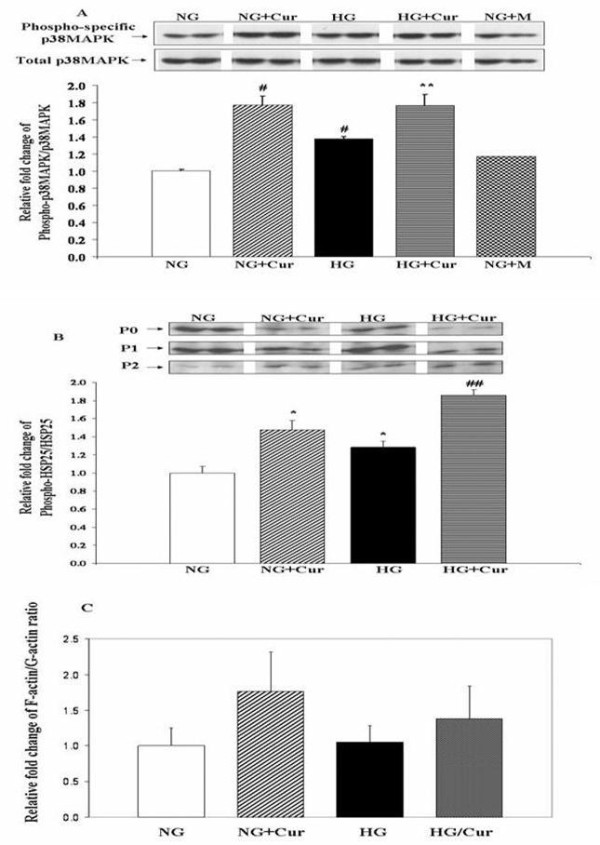
Curcumin activates p38MAPK and phosphorylates HSP25 in cultured Pods. 5.5 mM glucose (NG), 5.5 mM glucose+30 μM curcumin (NG+Cur), 30 mM glucose (HG), 30 mM glucose+30 μM curcumin (HG+Cur), 5.5 mM glucose+24.5 mM mannitol (NG+M). (a) Representative Western blots of phospho-specific p38MAPK (pp38MAPK) and quantitative evaluation of pp38MAPK relative to total p38MAPK (p38MAPK) by densitometric analysis. (b) Representative IEF separating total HSP25 into its nonphosphorylated isoform (P0), mono- (P1), and bi-phoshorylated (P2) isoforms, Western blots of HSP25, and quantitative evaluation of relative phosphorylated HSP25 isoforms to total HSP25 ((P1 + P2)/(P0 + P1 + P2)) by densitometry analysis. Mannitol values (n = 2) are not displayed but were similar to NG. (c) DNAse I assay of F-actin/G-actin ratios. All data expressed as mean ± SEM (n = 3). *P < 0.05 compared with NG; #P < 0.01 compared with NG; **P < 0.05 compared with HG; ##P < 0.01 compared with HG.